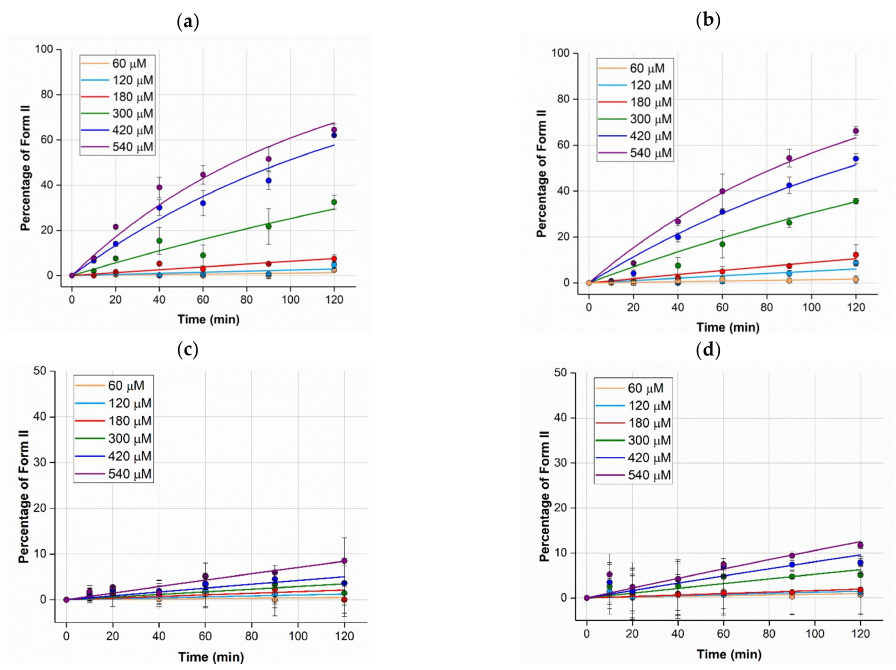
Figure 5. Plot of the percentage of form II vs. incubation time for the cleavage of pBR322 plasmid DNA (0.025 µ g/ µ L) by complexes: ( a ) 1-ClO 4 , ( b ) 1-Cl , ( c ) 2-ClO 4 , and ( d ) 3-ClO 4 , at varying concentrations (0–540 µ M ), pH 7.4 (10 m M MOPS buffer), and 37 ◦ C. The plots show the fitted function (Equation (1)) used to determine the observed rate constant, k obs at each complex